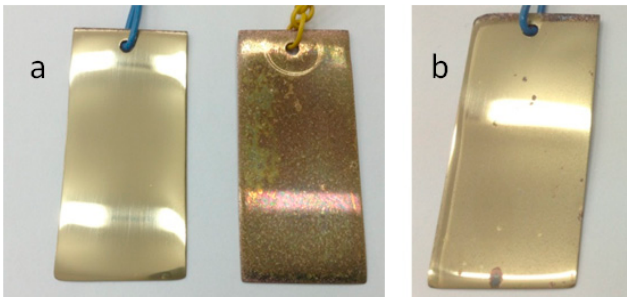
Figure 9. View of samples after corrosion tests: ( a ) samples with inhibitor and without after 4 cycles of tests; ( b ) sample with the applied inhibitor after 135 test cycles (5 days).